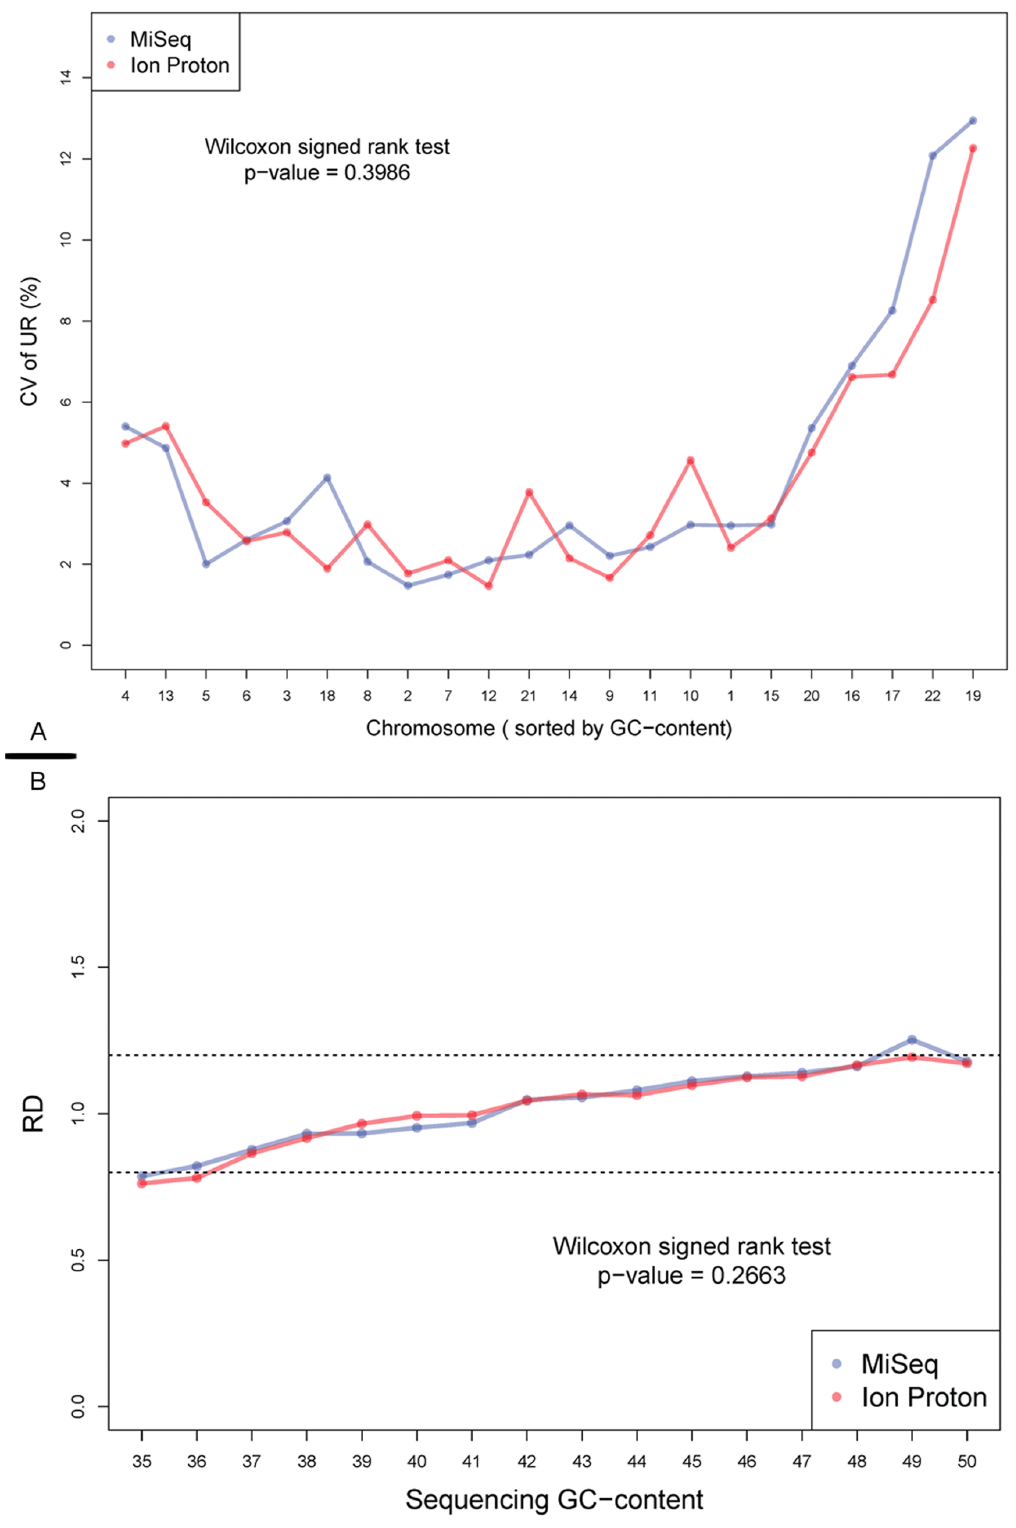
Figure 1. Characteristics of sequencing GC bias. A, Coefficient of Variation of sequencing reads from two platforms on each chromosome. This correlation between CVs of UR% from 18 samples (y-axis) and GC-content of each chromosome (x-axis, sorted by GC content) are shown in this figure. The color-code lines represented data generated on MiSeq (blue) and Ion Proton (red) platform, respectively. B, Average RD in each GC content category. The blue line (MiSeq) and red line (Ion Proton) shows the relative depth (RD, y-axis) at each sequencing GC-content 1 Mbp windows (x-axis). The dash lines represent the RD from 0.80 to 1.20.